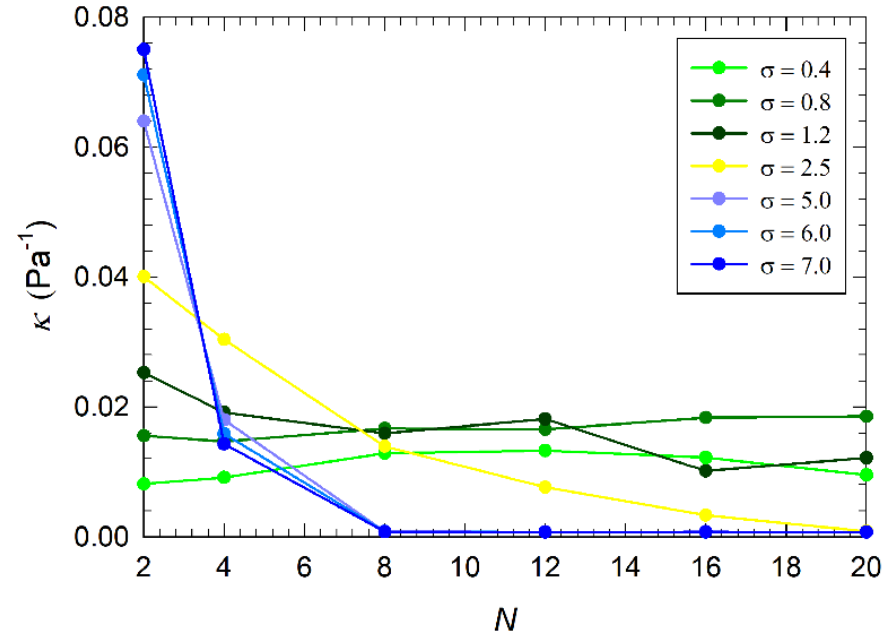
Figure 7. Osmotic compressibility κ as a function of the grafted chain length N for all grafting densities σ considered in this study.